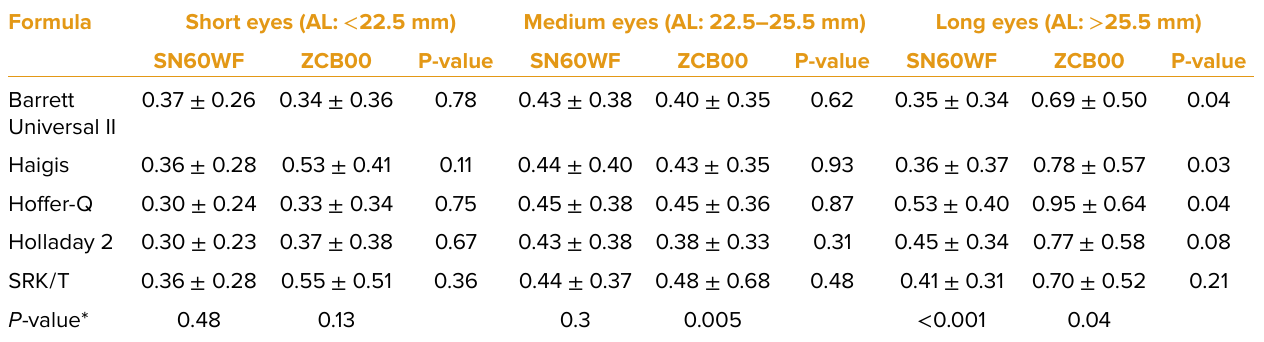
Table 4. Mean absolute error (MAE) for SN60WF and ZCB00 lenses in short, medium, and long eyes.